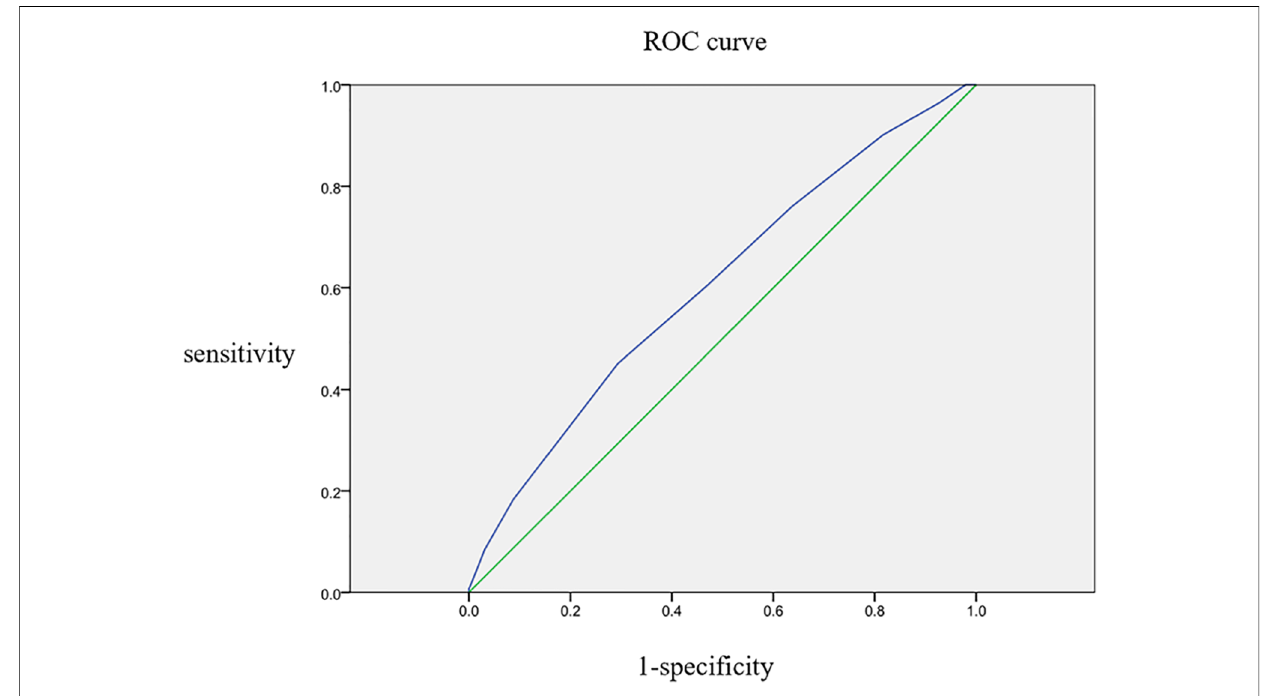
FIGURE 2 ROC curve of Autar score for predicting DVT in patients with pelvic or lower-extremity